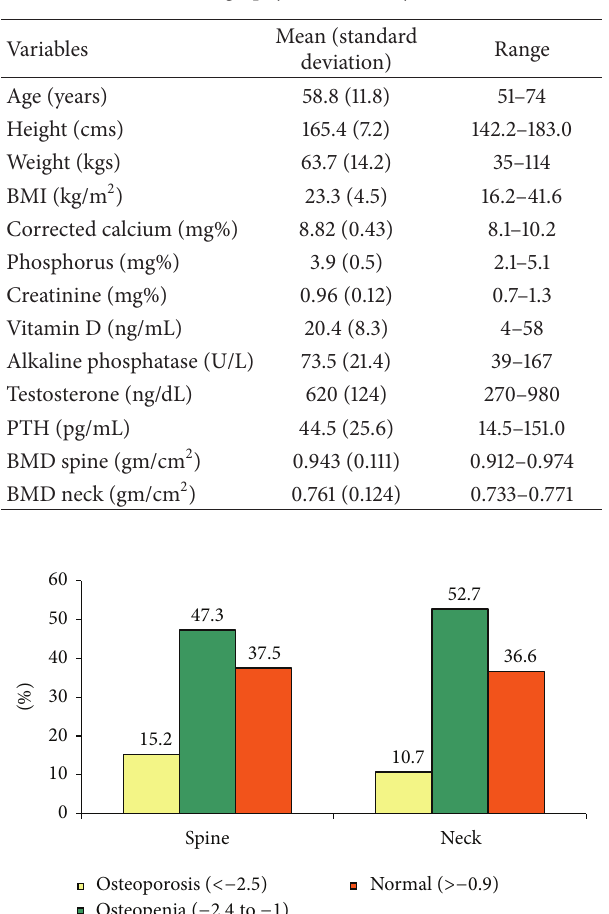
Table 1: Demography, biochemistry, and BMD.